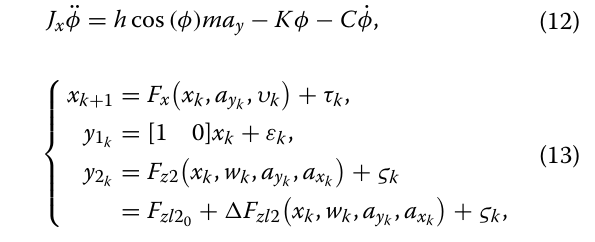
and dampness of the vehicle, and the equivalent rota- tional inertia) based on a roll model. In addition, the other parameters (the equivalent stiffness of the anti- roll bar, and the equivalent CG position of each part) are identified using the vertical force model in Section 2. The details of the ATEKF estimation module are shown in Figure 3. The nonlinear roll model is described through Eq. (12). The state-space model in the estimation can be described using Eq. (13). In the equation, τ k is the process noise, and ε k and ς k are the observation noise. In addition, υ and w are the parameters of the dynamics model (Eq. (12)) and Part 2 (Eqs. (6)–(8)). The other symbols are described in “Nomenclature”.